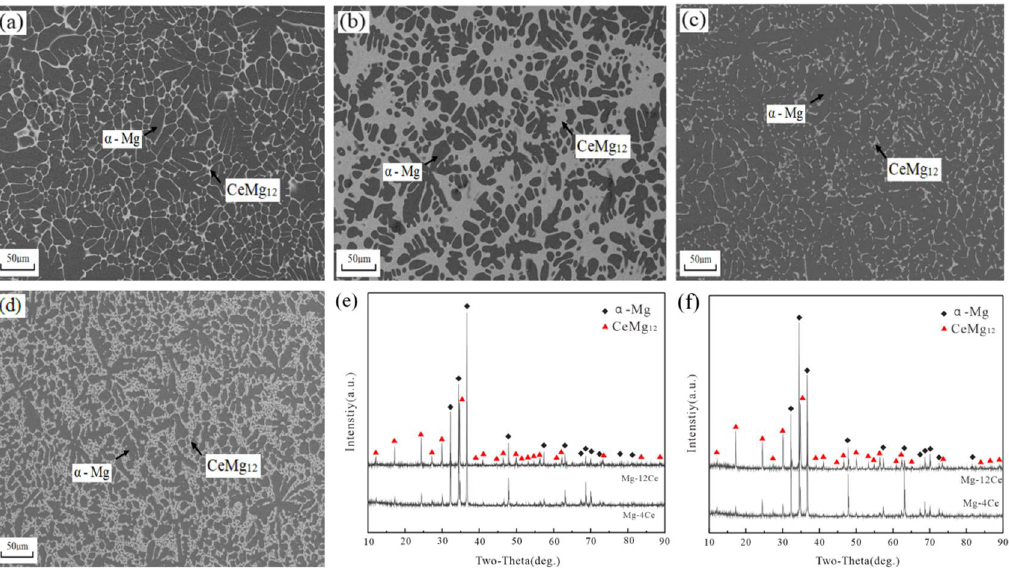
Figure 4. BSE micrographs of ( a ) the as-cast Mg-4Ce alloy, ( b ) the as-cast Mg-12Ce alloy, ( c ) the annealed Mg-4ce alloy, and ( d ) the annealed Mg-12Ce alloy; and XRD diffraction patterns of ( e ) the as-cast Mg-4Ce and Mg-12Ce alloys, and ( f ) the annealed Mg-4Ce and Mg-12Ce alloys.